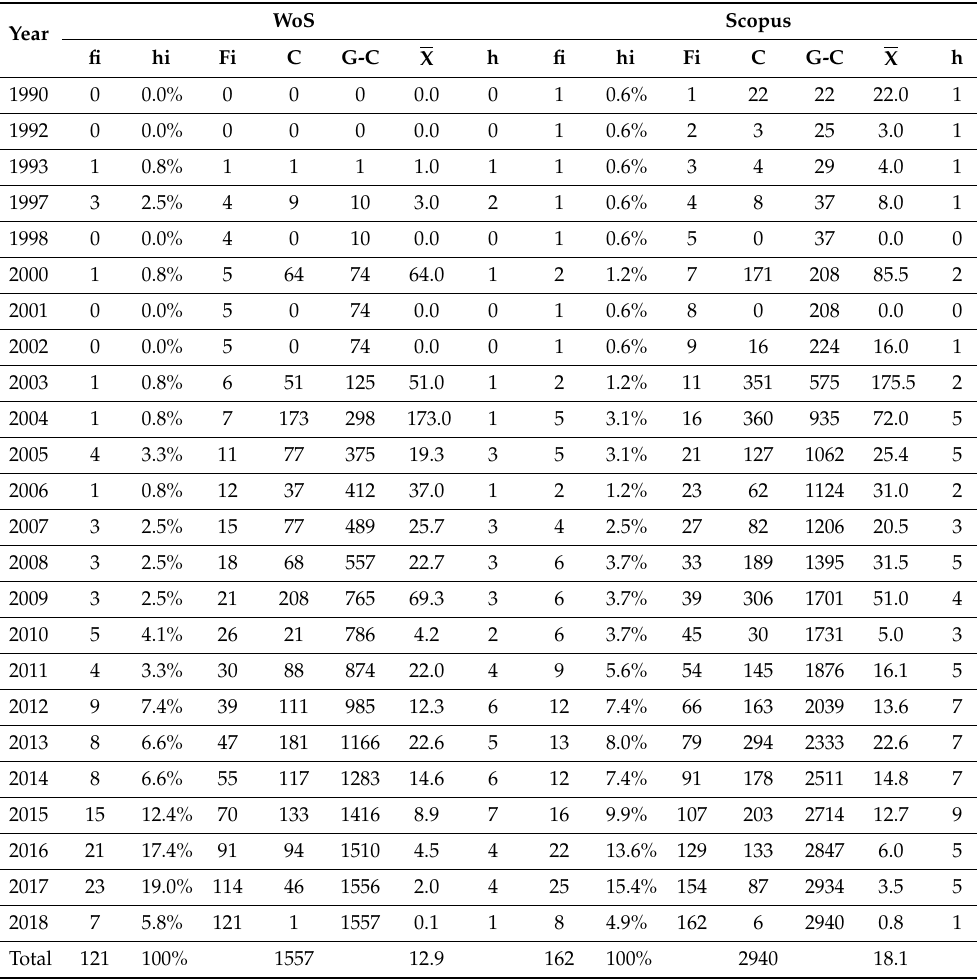
Table 1. Production of articles in Web of Science (WoS) and